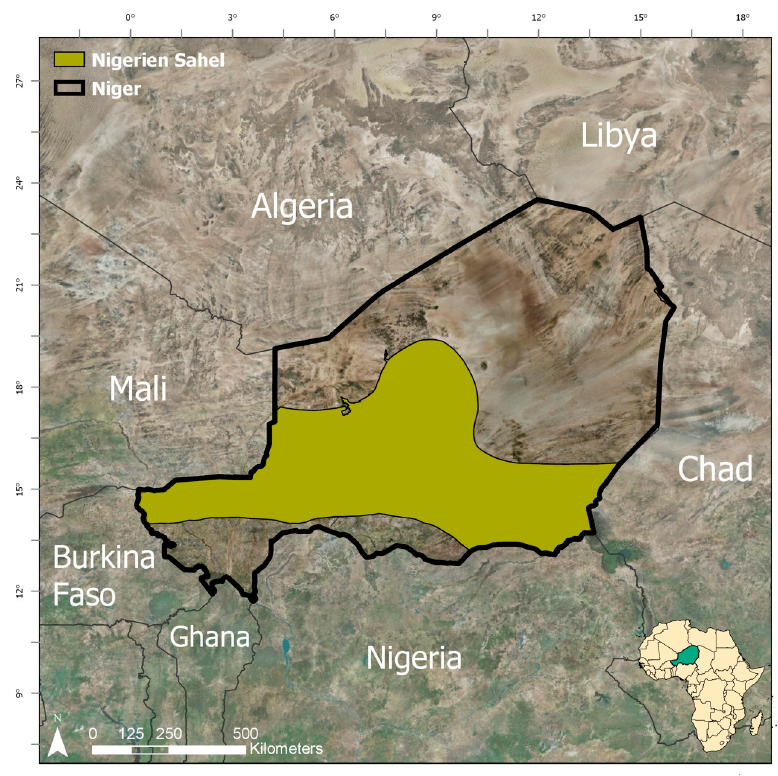
Figure 1. The Nigerien Sahel.